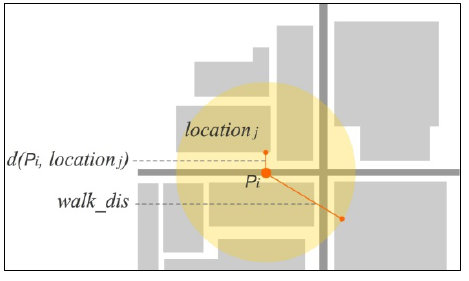
Figure 2. Allocating taxi O/D points to land use